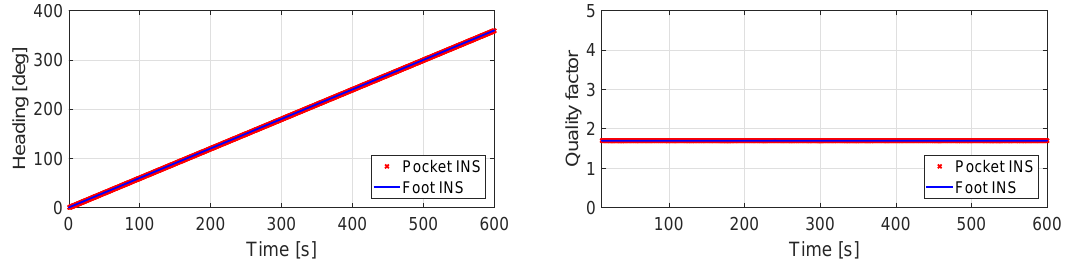
Figure 8. ( Left ) Heading estimation of the pocket INS and the foot INS of a still IMU with 0.6 ◦ /s constant bias in the z -axis of the turn rate measurements; ( Right ) Quality factor estimation of the heading estimations.